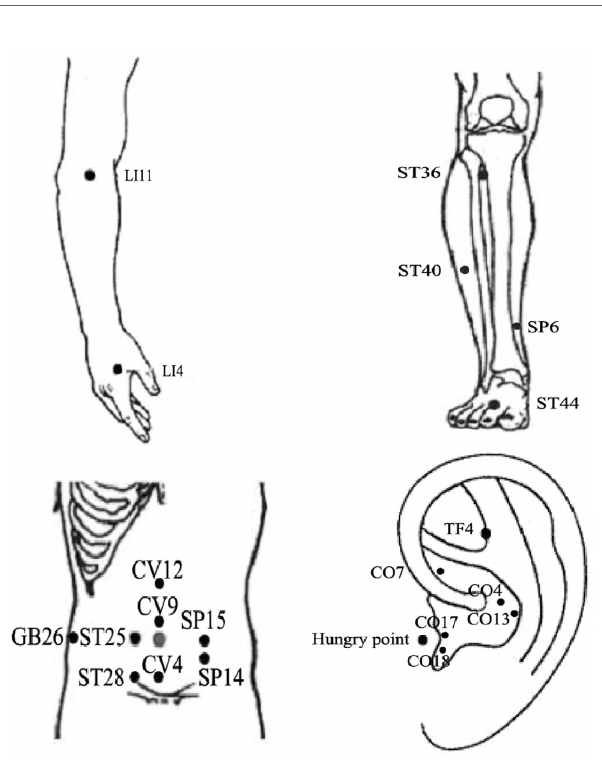
FIGURE 4 | The location of frequently chosen acupoints on humans for the treatment of obesity.